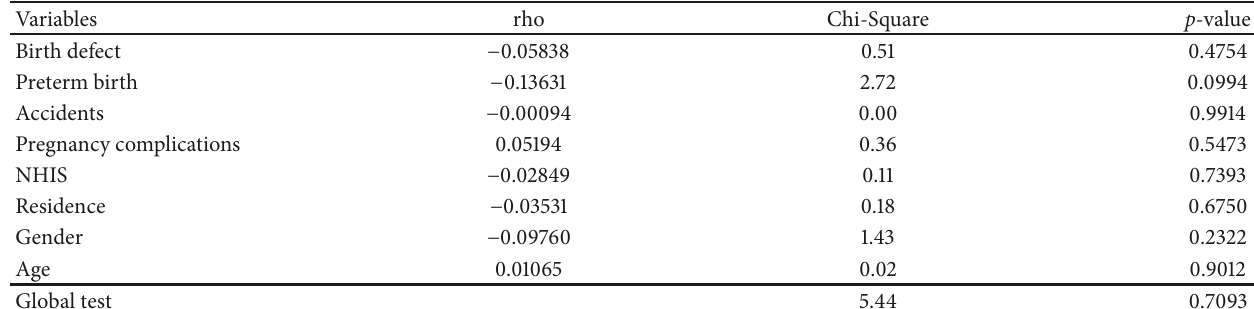
Table 4: Infant mortality: test of Cox proportional hazard model